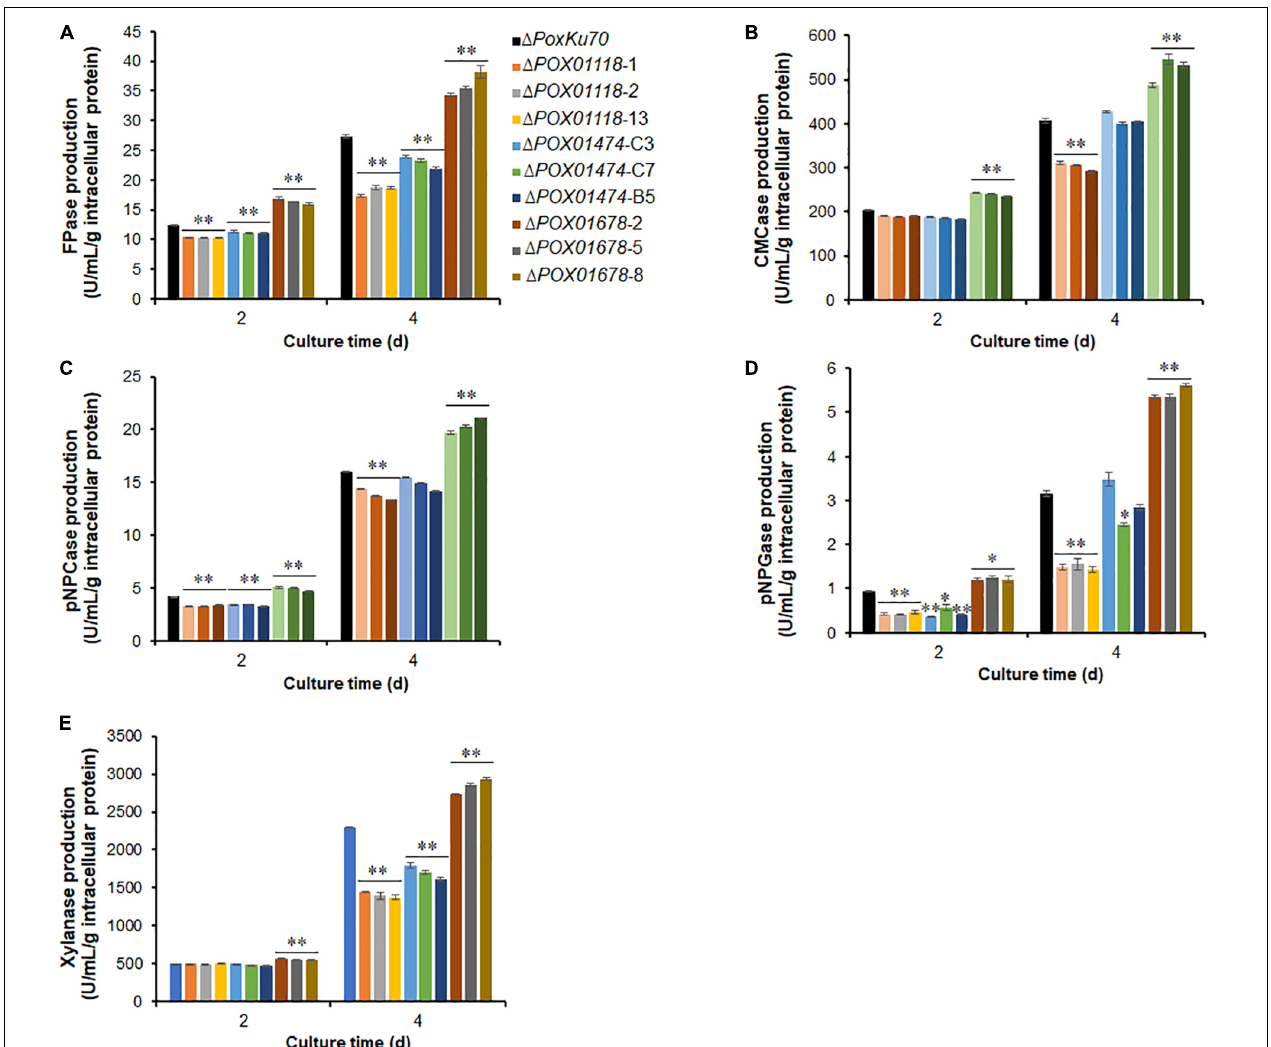
FIGURE 15 | Cellulase and xylanase activities of three P. oxalicum deletion mutants (cid:49) POX01118 , (cid:49) POX01474 , (cid:49) POX01678 and the parental strain (cid:49) PoxKu70, cultivated in medium containing Avicel after a transfer from GLU. (A) FPase; (B) CMCase; (C) pNPCase; (D) pNPGase; (E) xylanase. The experiments were carried out using three independent transformants of each gene. Enzymatic activities were determined at 2–4 days of cultivation. Enzymes activities were normalized by total intracellular proteins. ∗ p ≤ 0.05 and ∗∗ p ≤ 0.01 indicate significant differences between deletion mutants and parental strain (cid:49) PoxKu70 by Student’s t- test.